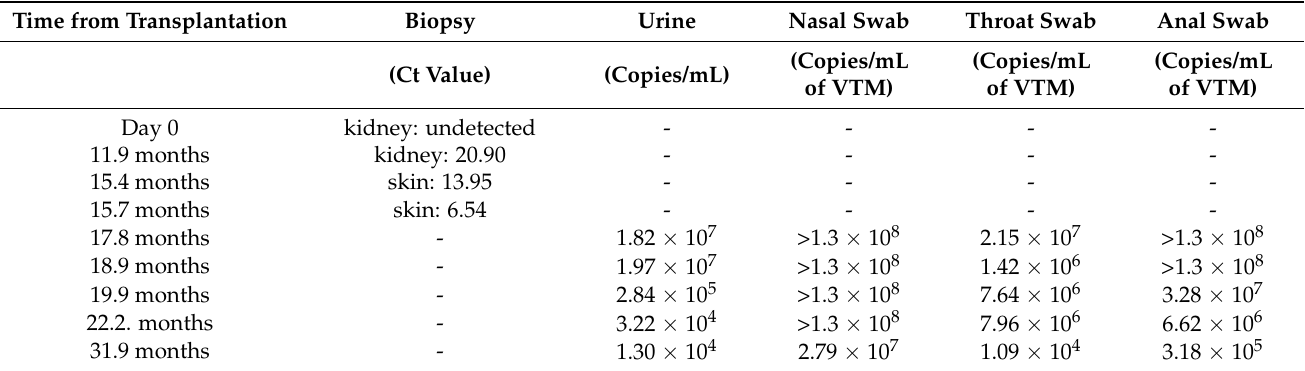
Table 1. Trichodysplasia spinulosa polyomavirus (TSPyV) real-time PCR results in diverse clinical specimens of a kidney transplant recipient during a 32-month follow-up period.